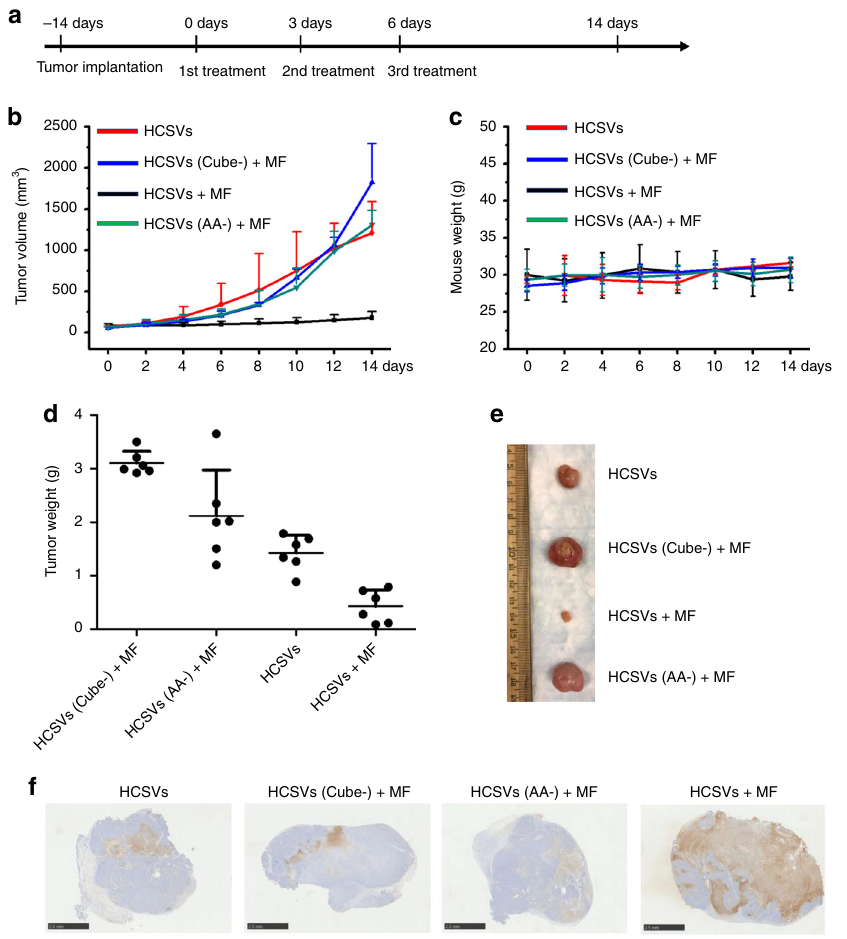
Fig. 3 Combination therapy-mediated antitumor effect in a TRAMP-C1 tumor model. a in vivo treatment timeline. b tumor growth curves of the TRAMP- C1. c the record of mouse weight. d tumor weight at the end time point. ( n = 6 independent samples). Data are shown as means ± s.d. e the typical ex